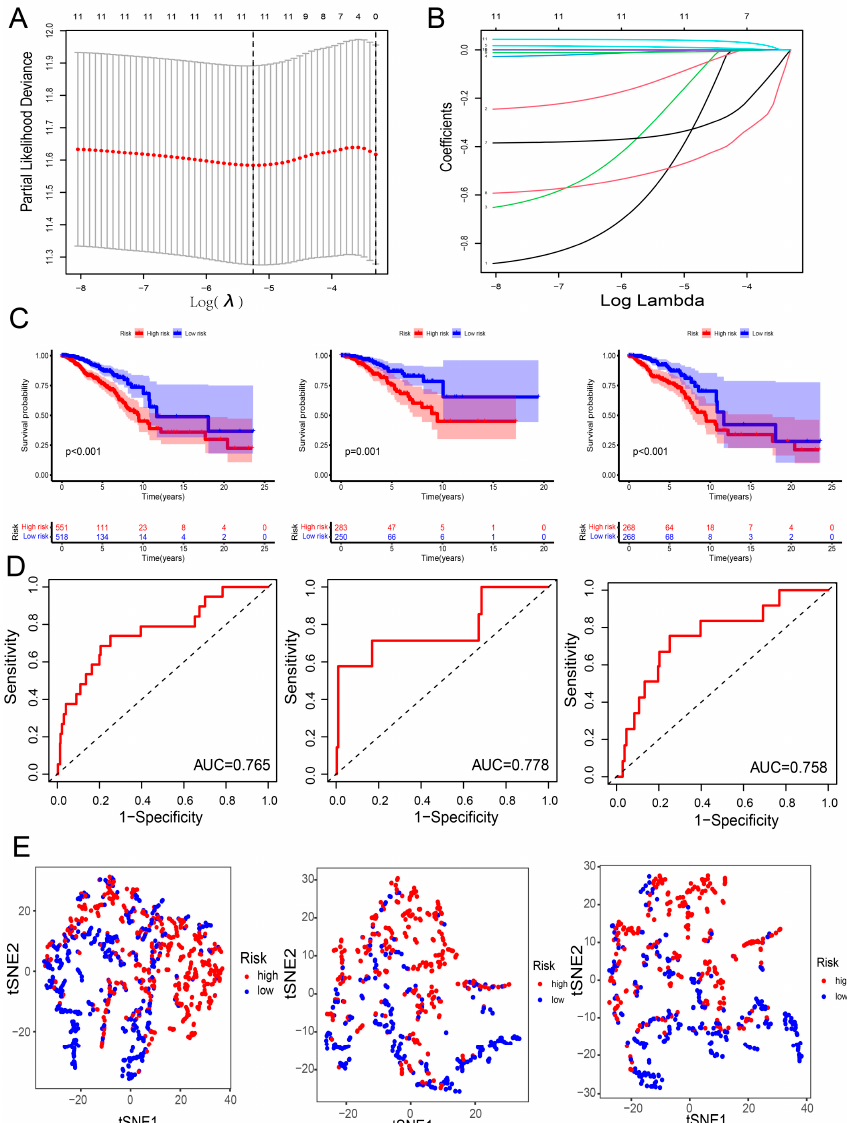
Figure 4. Identification of innate immune-related prognostic and constructed the risk model in breast cancer. The distribution of the partial likelihood deviation of the LASSO coefficient was shown in ( A ). ( B ) Exhibition of the LASSO coefficients of 11innate immune prognostic signatures. ( C ) Firstly, the sample of breast cancer patients were randomly divided into entire group, training group and a test group for prognostic analysis. Kaplan–Meier survival analysis between the high-risk group and the low-risk group of breast cancer patients of entire-set, training set and test set. ( D ) ROC curve of the risk prognostic model in breast cancer patients of entire-set, training set and test set. ( E ) The distribution of the risk score in breast cancer showing through PCA analysis.